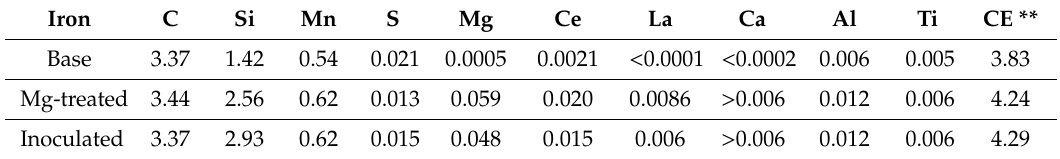
Table 2. Chemical composition of the test cast irons (wt.%) *.